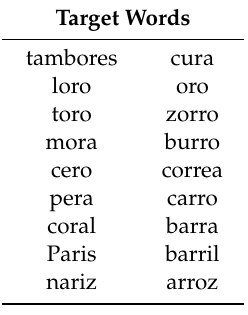
Table A1. Target words used in the picture naming